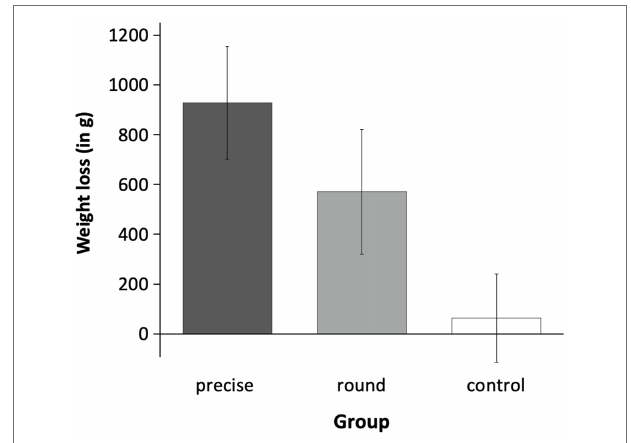
FIGURE 1 | Weight loss in Experiment 1. The three experimental conditions (precise goal vs. round goal vs. control) differed significantly in weight loss. Contrast analyses showed that—considered jointly—both goal groups lost significantly more weight than the control group. This significant contrast was driven in particular by the precise goal condition. Error bars represent ±1